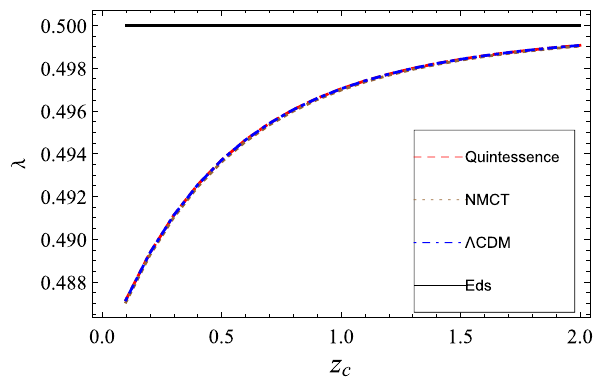
Fig. 8 The behavior of ξ versus z c for the Λ CDM , quintessence, Eds and NMCT